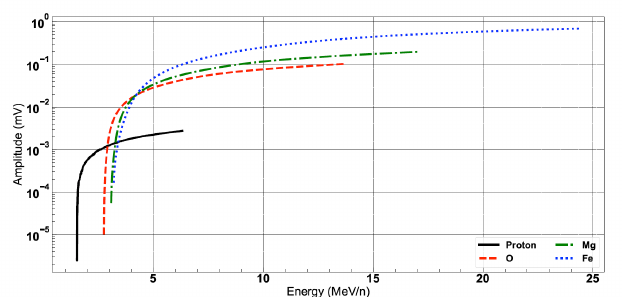
Fig. 5. Amplitude versus energy for different kinds of particles (proton, oxygen, magnesium and iron). If we assume that the kind of particle is known from the rise time measurement (see Fig. 2), the amplitude allows measuring the energy of the particle on a wide range above 5 MeV.